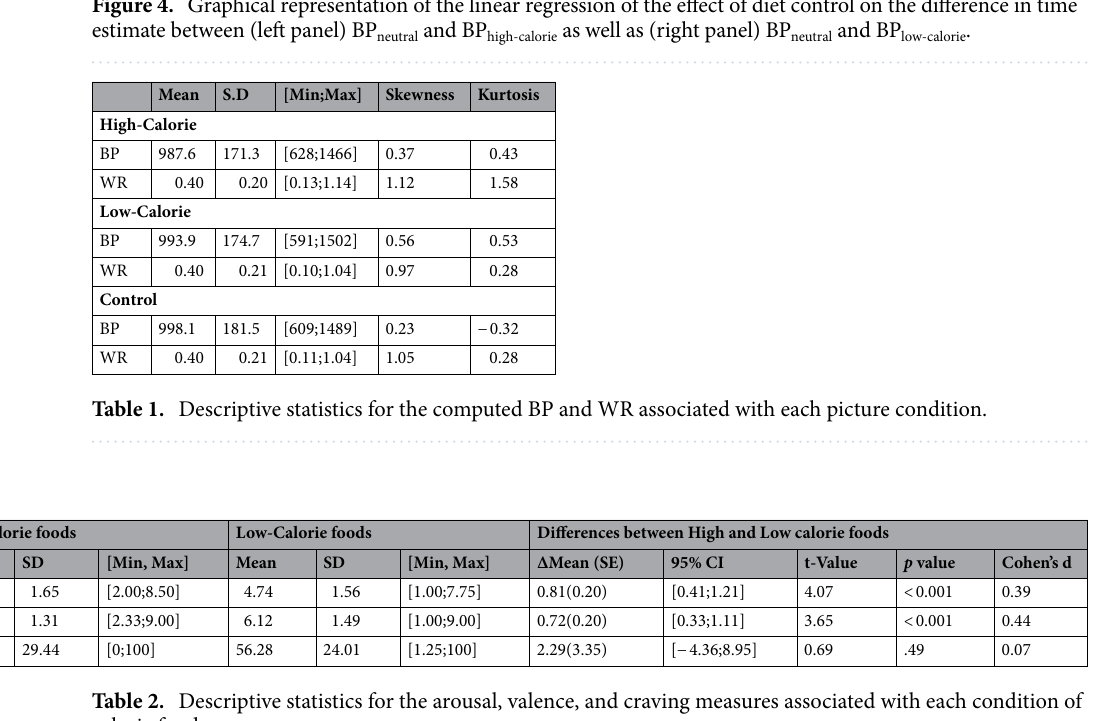
Table 2. Descriptive statistics for the arousal, valence, and craving measures associated with each condition of calorie foods.